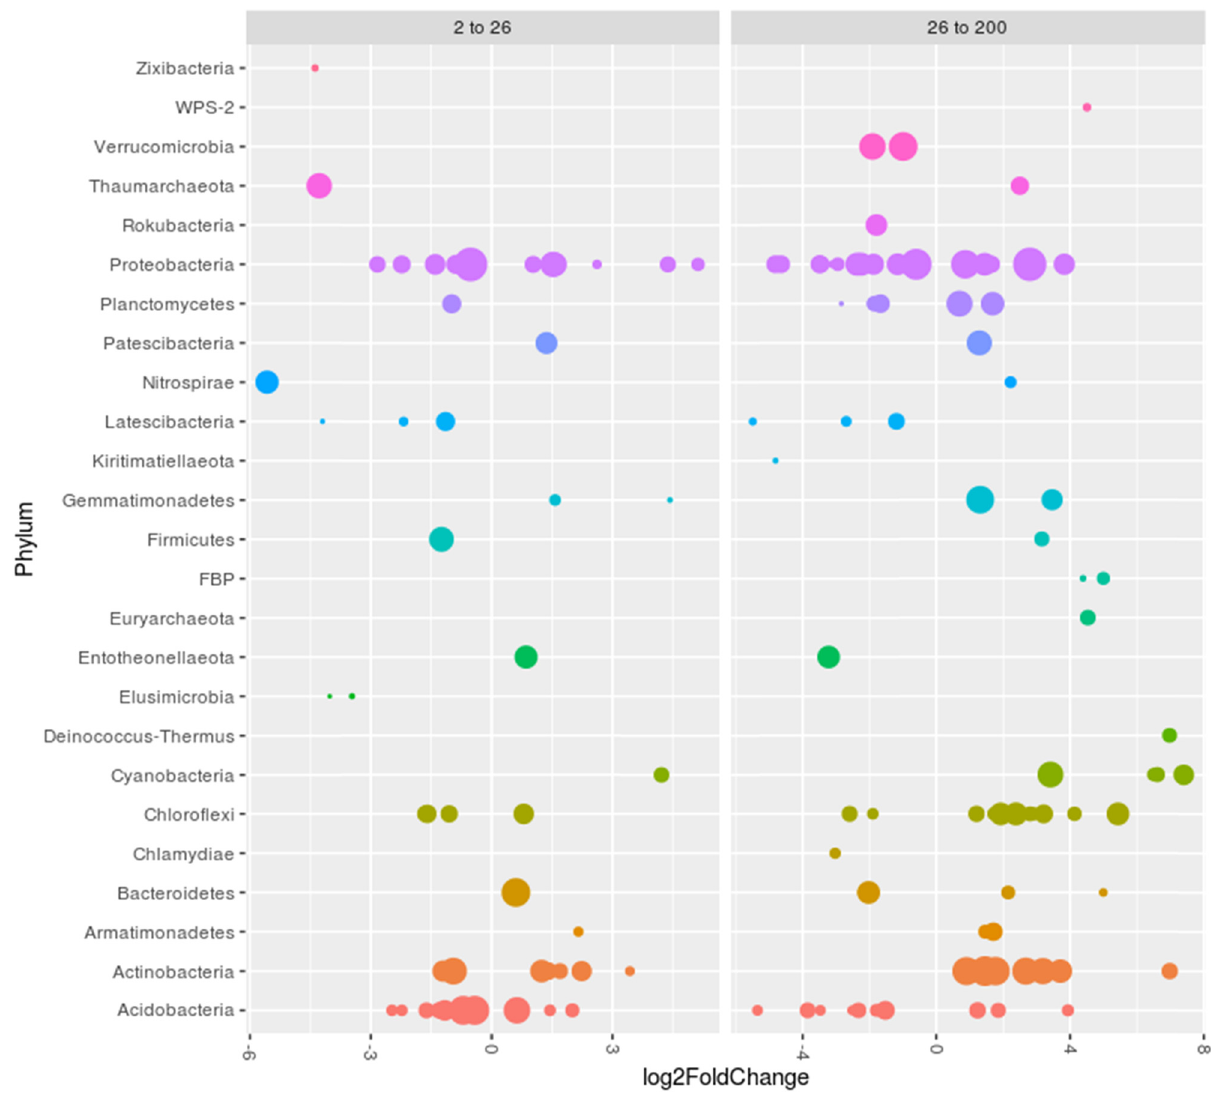
Figure 6: Changes in abundances of di ff erent OTUs at phyla level in soil comparisons of di ff erent ages.